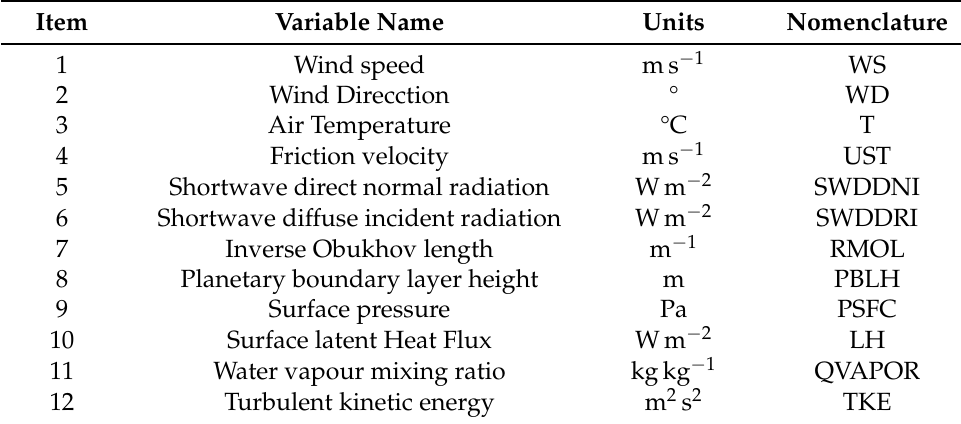
Table 1. Selected features from the mesoscale data.